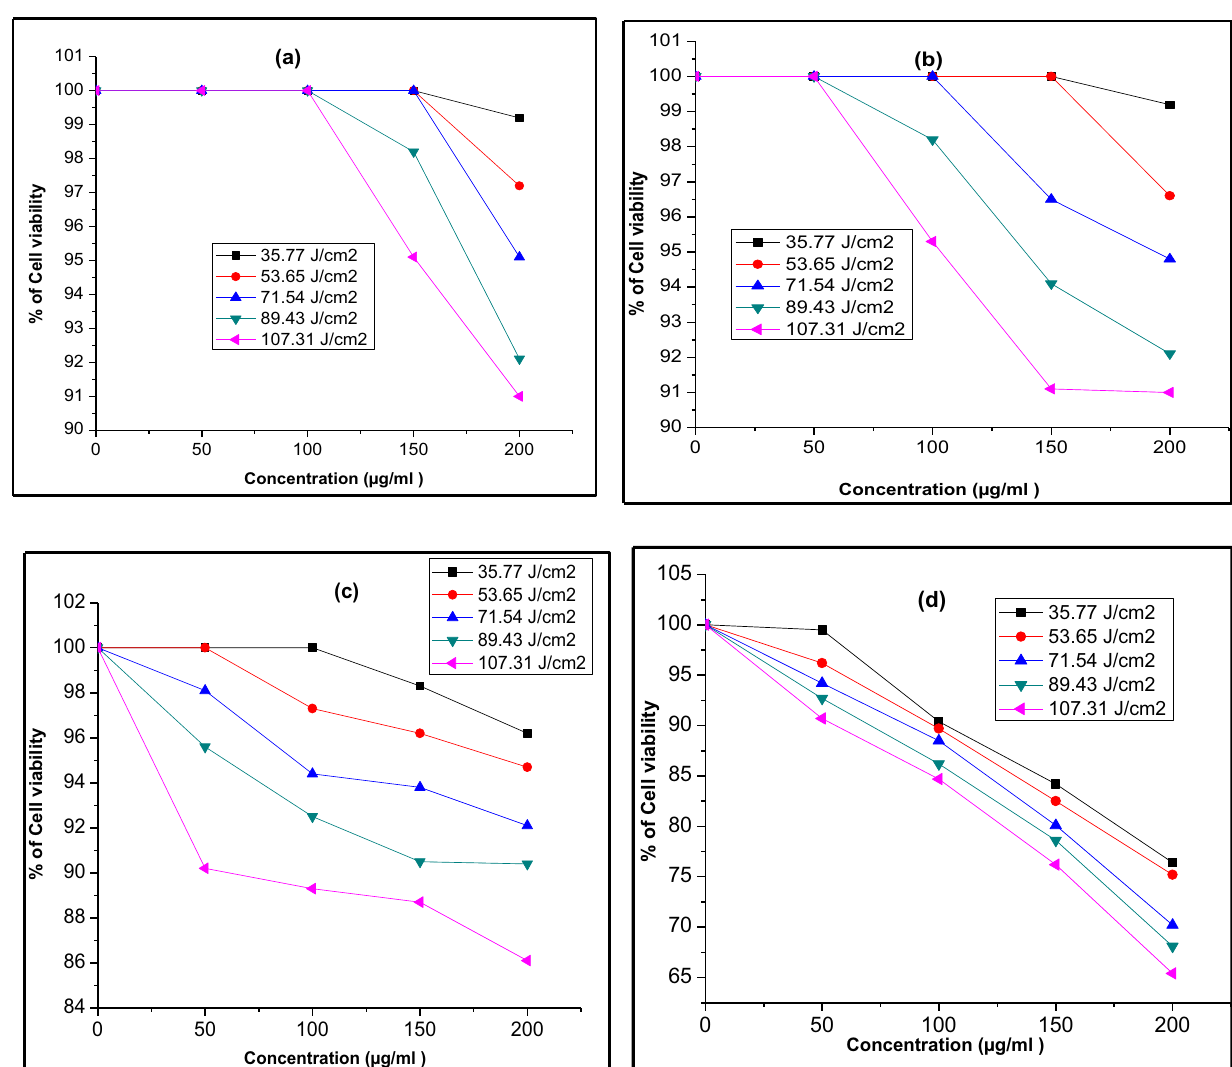
Figure 11. Cell viability of CT nanocomposites on HeLa cells after ( a ) 8 h, ( b ) 12 h, ( c ) 16 h and ( d ) 24 h of